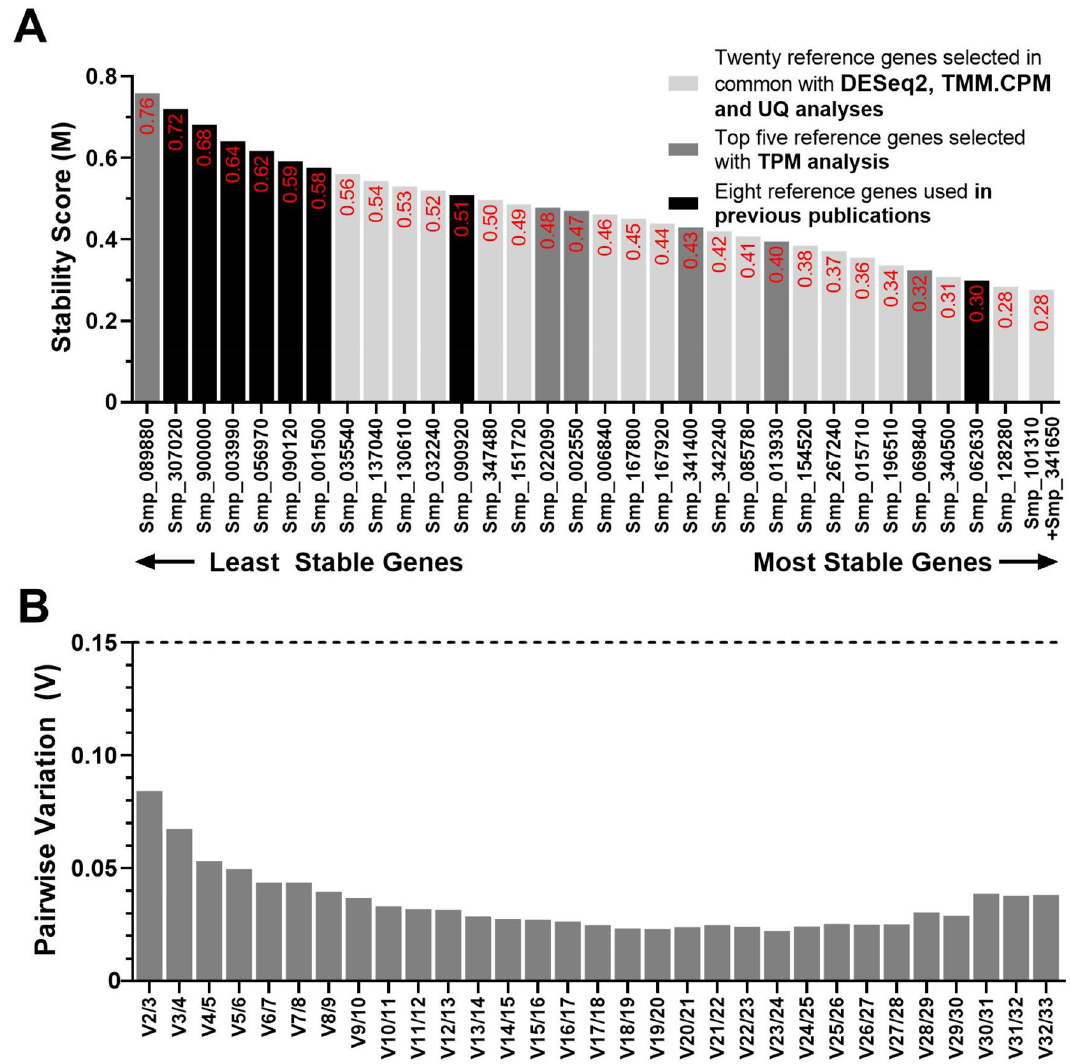
Figure 4. Gene expression stability and ranking of the 33 candidate reference genes across six S. mansoni developmental stages measured by RT-qPCR and analyzed with geNorm. ( A ) Expression stability scores (M) of all candidate reference genes are represented at the column bar’s top. Genes were colored based on their selection method: genes selected with DESeq2, TMM.CPM and UQ RNA-Seq normalization methods are shown in light grey bars; genes selected with TPM RNA-Seq normalization method are shown in dark grey bars, while genes used in previous works are shown in black bars. The higher the stability score, the least stable the gene. ( B ) Pairwise variation (Vn/n + 1) analysis between the normalization factors NFn and NFn + 1 to determine the optimal number of reference genes required for accurate normalization, where n is the number of genes involved in the normalization factor. The cut-off value determined by this analysis is